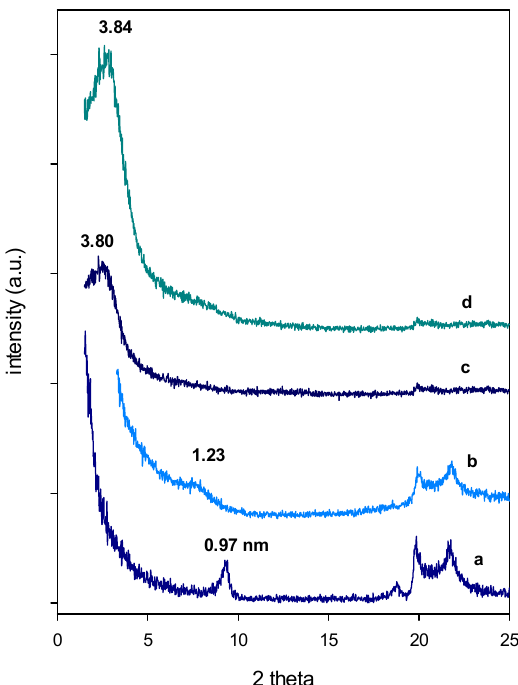
Figure 2. Powder XRD patterns of calcined ( a ) starting raw, ( b ) after reaction with C 12 amine, and TEOS. ( c ) Al-PCH and ( d ) Zr-PCH after calcination at 550 °C.